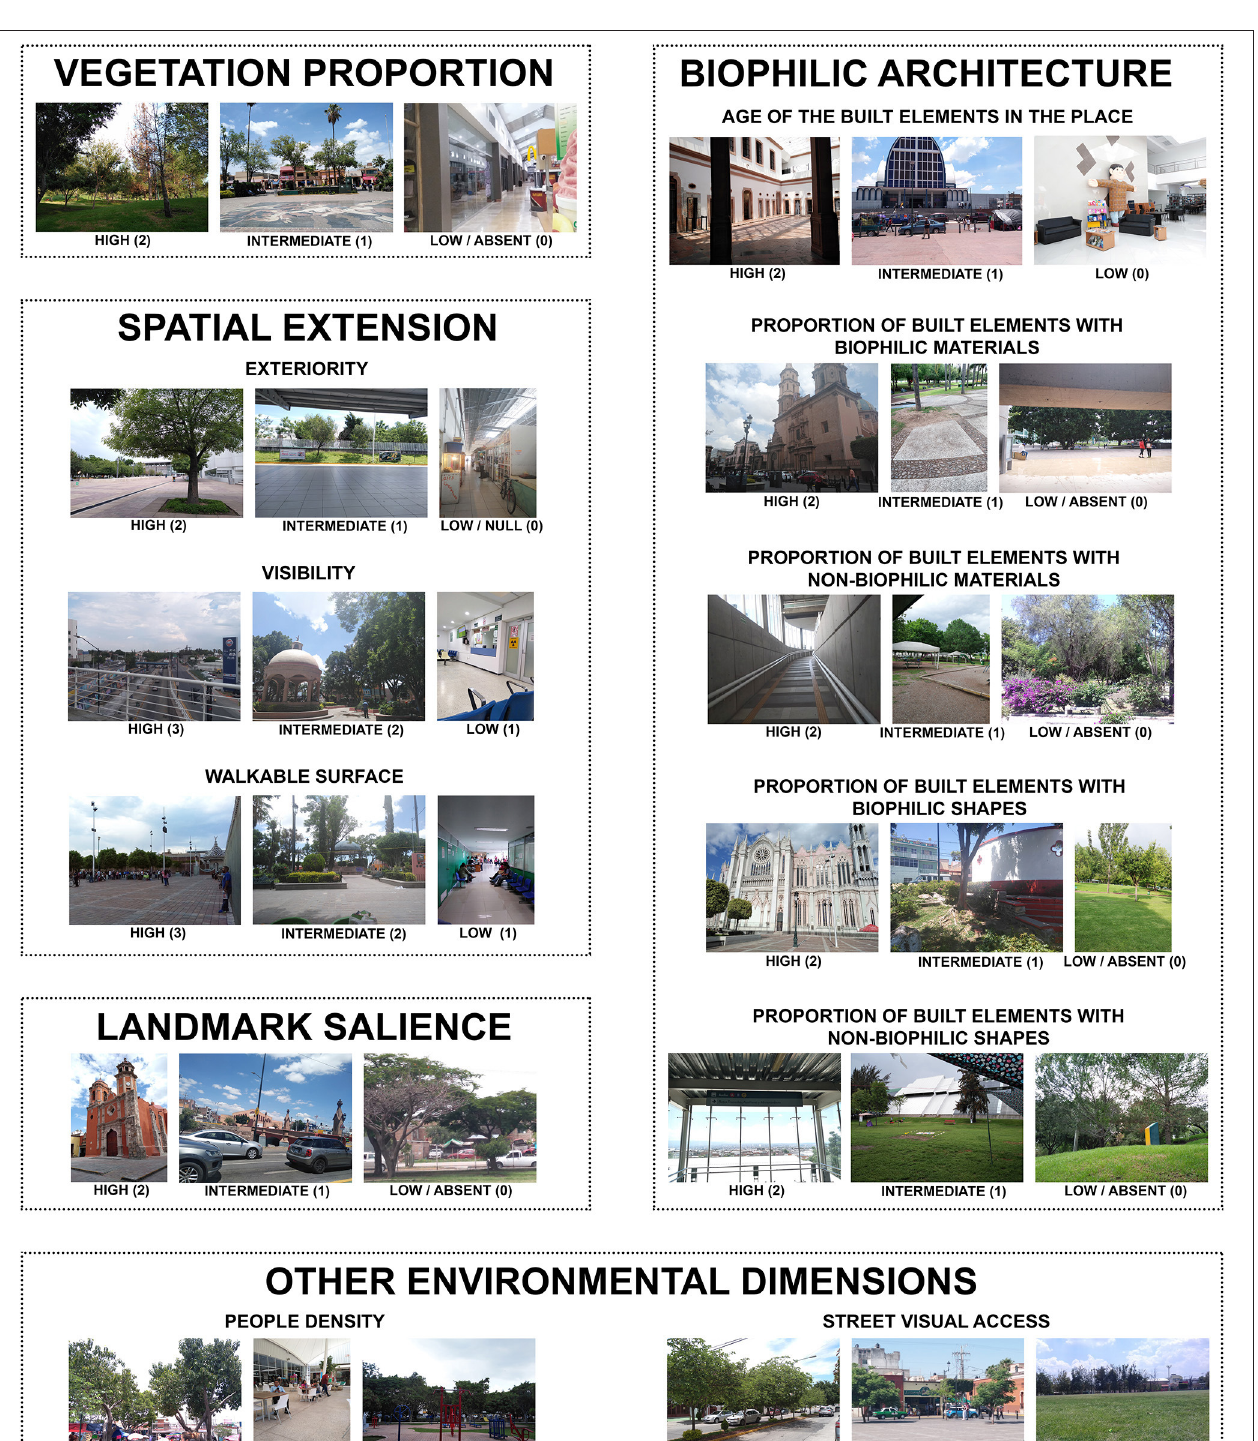
FIGURE 2 | Environmental dimensions exemplified with one photograph for each of the three levels of the corresponding dimension.